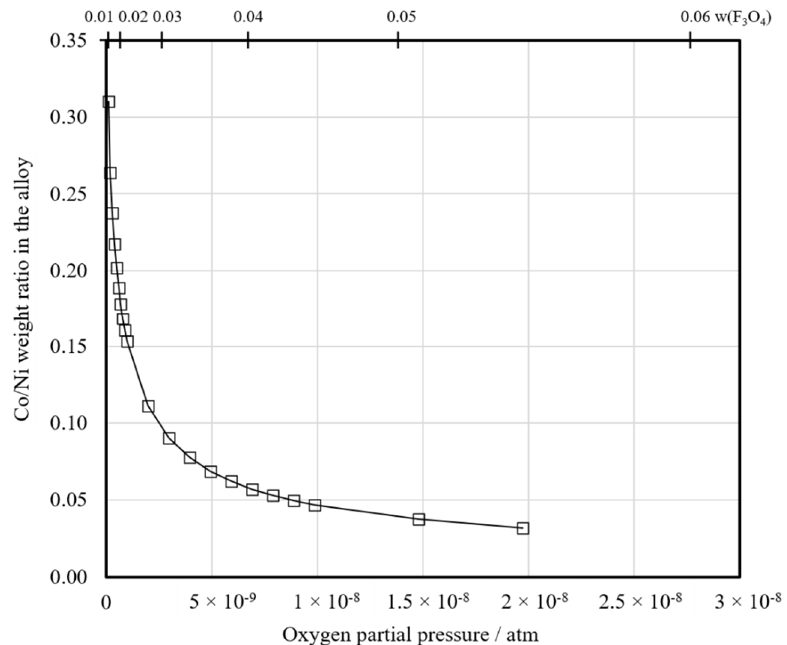
Figure 13. Isothermal section of the SiO 2 –FeO–Fe 2 O 3 slag equilibrium system at 1400 °C. The black circles refer to the calculated slag compositions based on the initial composition of Series 3. The red lines are oxygen isoactivity contours (and their labels are the log 10 of oxygen partial pressure / atm) calculated with MTDATA software and the MTOX 8.2 database [48]. The phase labels are COR = Fe 2 O 3 , HAL = FeO, OX_LIQ = slag, SP = Fe 3 O 4 , and TRI = tridymite (SiO 2 ).